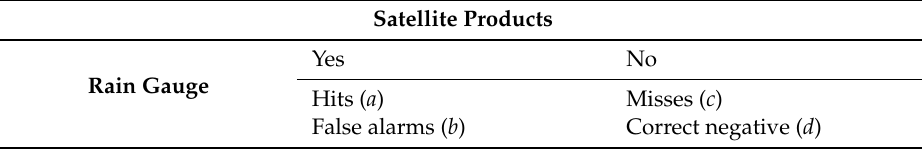
Table 3. Contingency table for evaluating precipitation occurrence by satellite products.